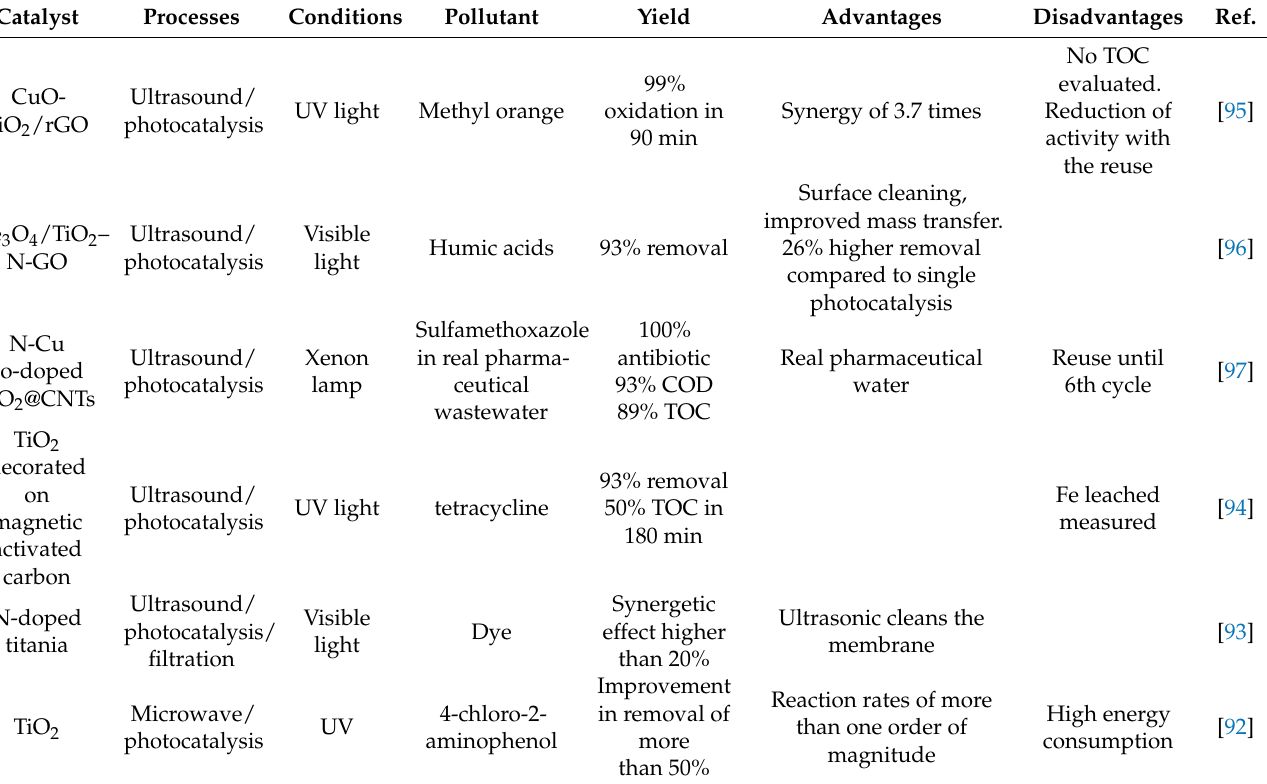
Table 6. Catalysts devoted to the combination of radiation and